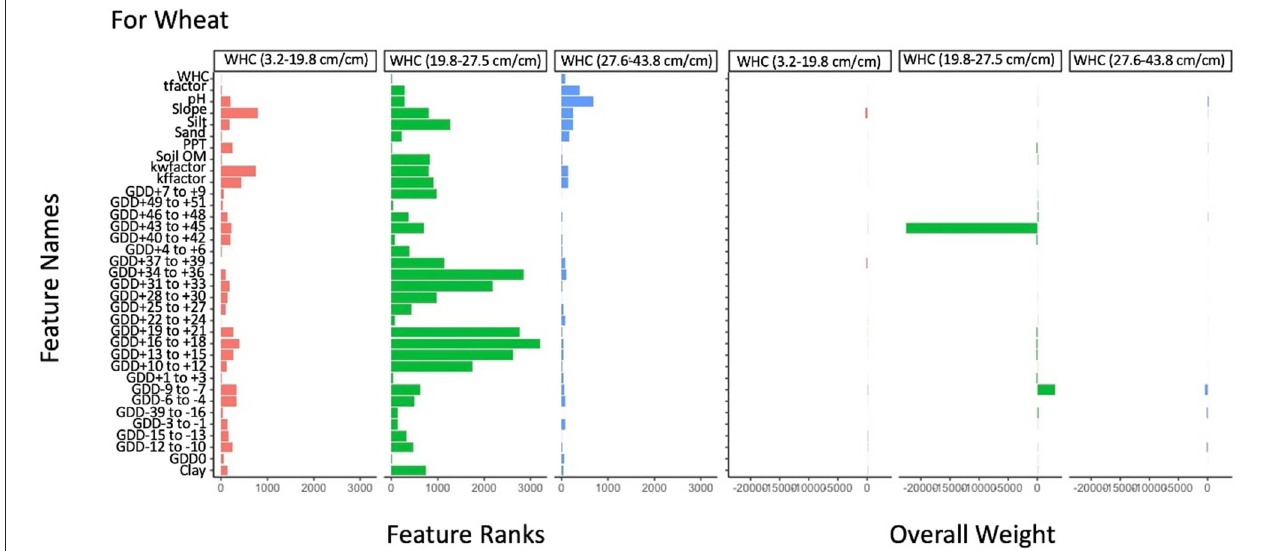
FIGURE 13 | Feature ranks and overall weight of features following explainable machine learning interpretations for wheat for low, medium, and high quartiles of water holding capacity.